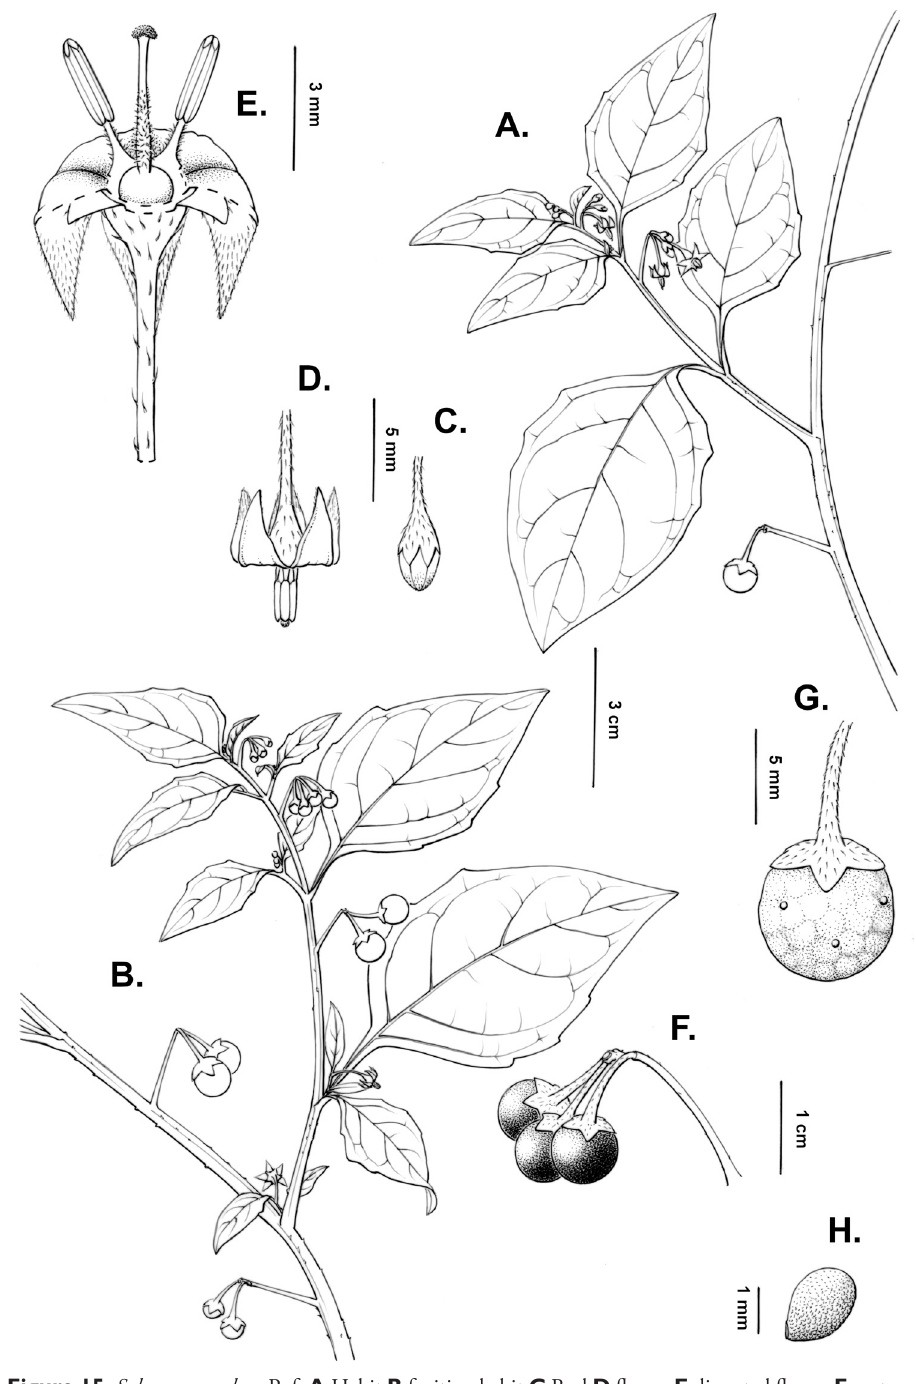
Figure 15. Solanum emulans Raf. A Habit B fruiting habit C Bud D flower E dissected flower F mature fruits G dried berry H seed ( A–H Ruth 687 ). Drawing by C.